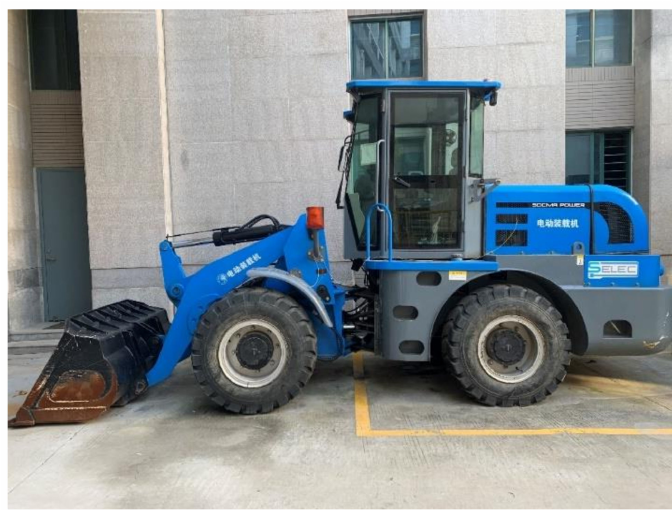
Figure 18. Test prototype of the 1.6 t pure electric